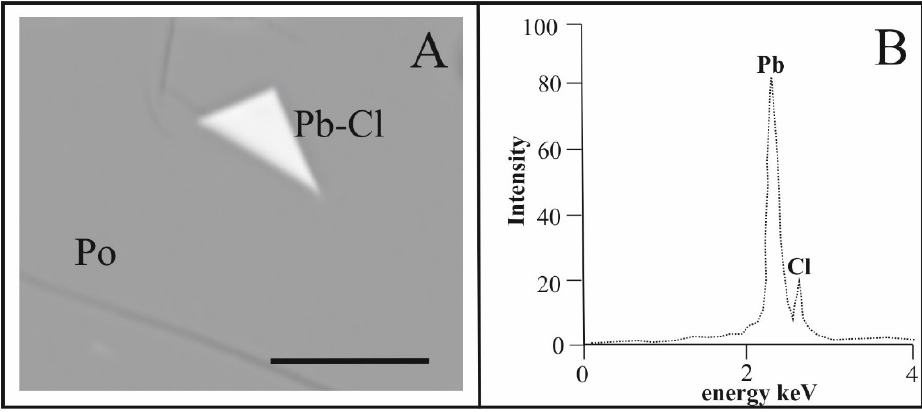
Figure 5. ( A ) BSE image of a Pb-Cl mineral (Pb-Cl) enclosed in pyrrhotite (Po), scale bar = 10 µm, and ( B ) its EDS spectrum (see the text for the Pb-S overlap).